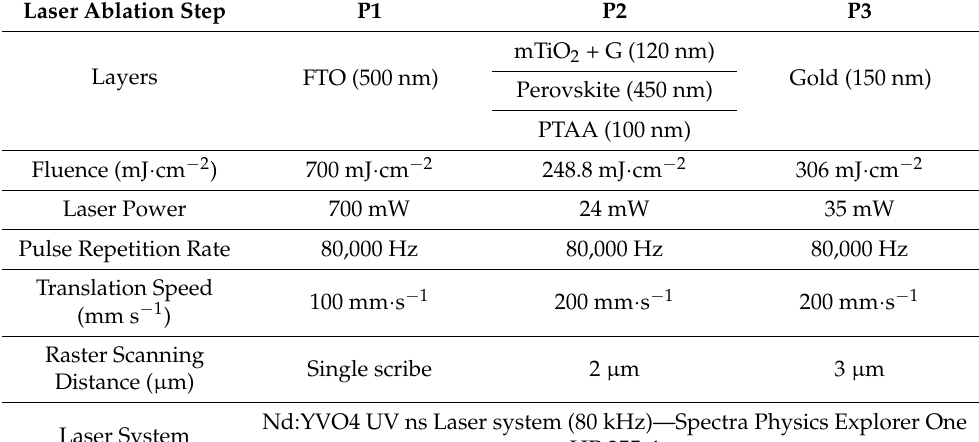
Table 3. Parameter sets optimized for each laser process (P1, P2, P3) employed in the PSM fabrication.